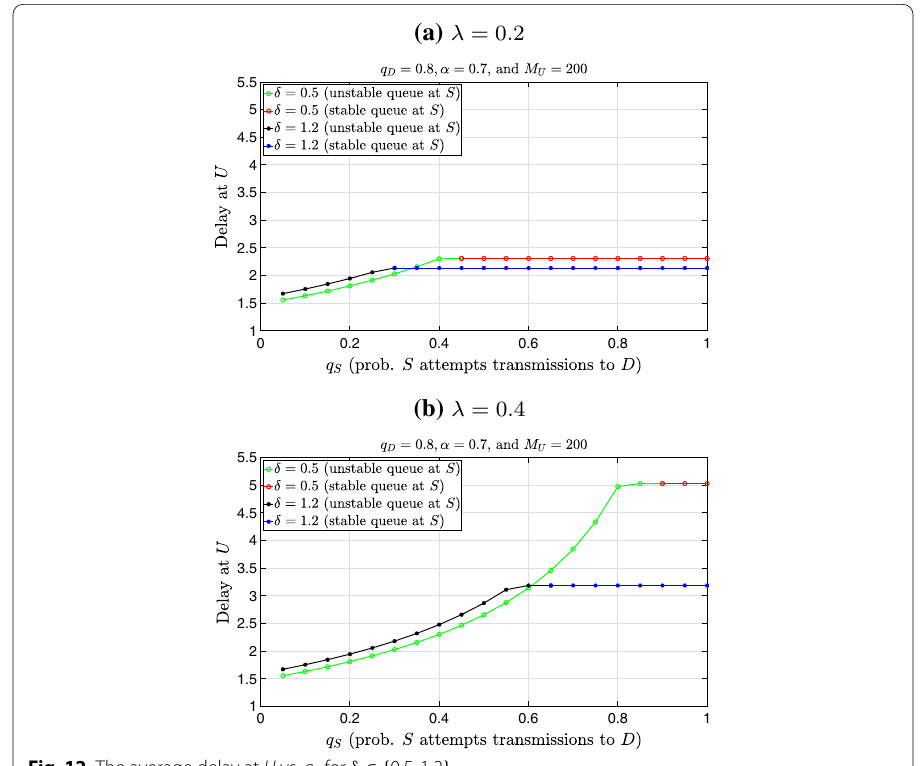
Fig. 12 The average delay at U vs. q S for δ ∈ { 0.5,1.2